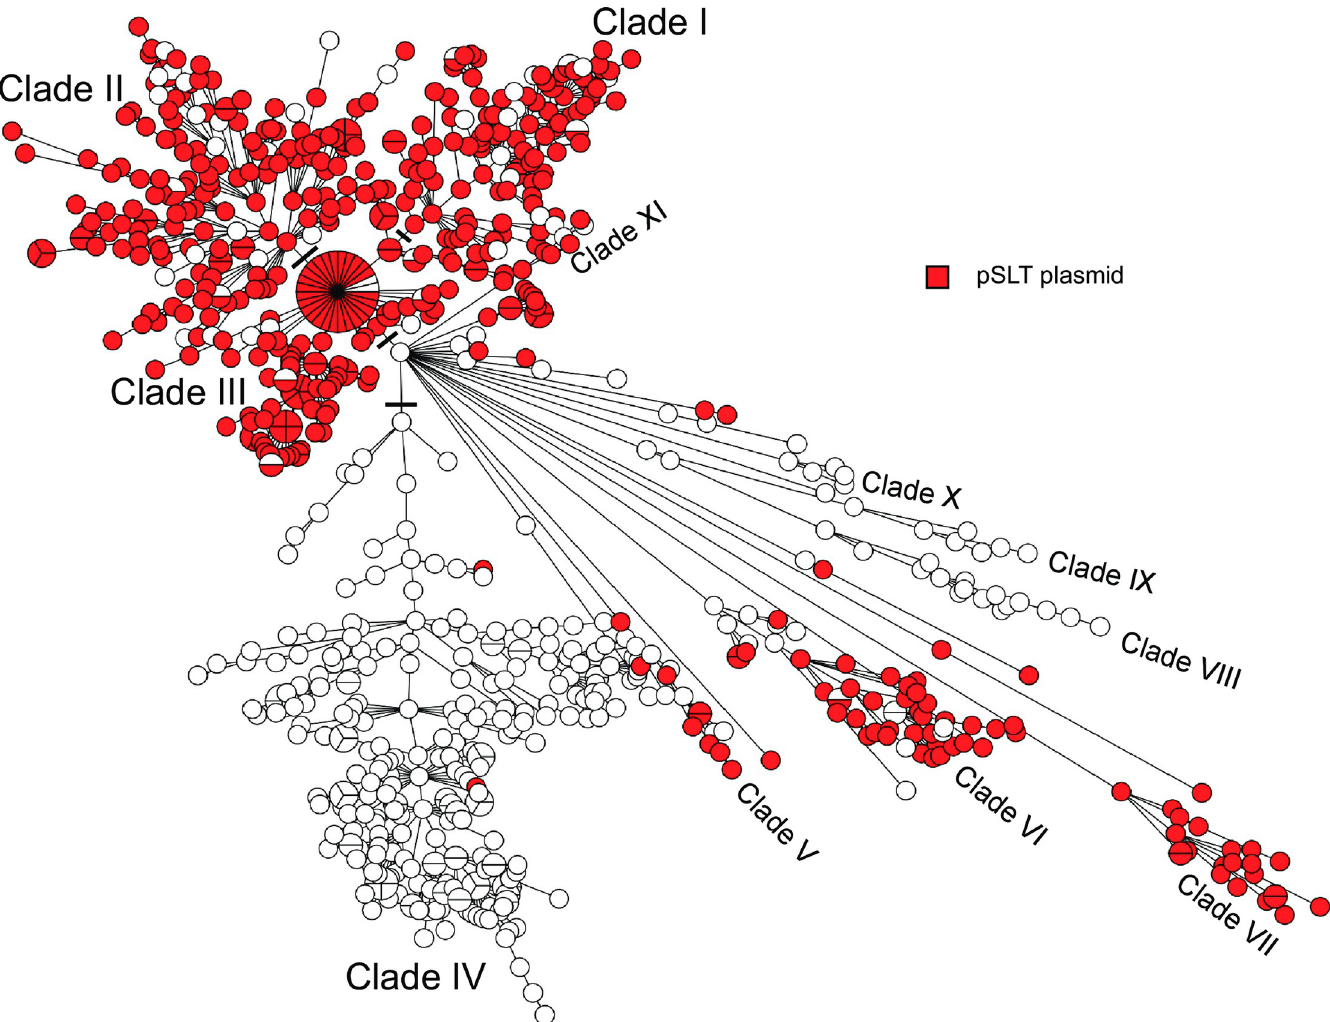
Fig 10. Minimum spanning tree of wgMLST data showing the distribution of the pSLT plasmid in the population of isolates used in this study. The MST analysis was performed as for Fig 5.